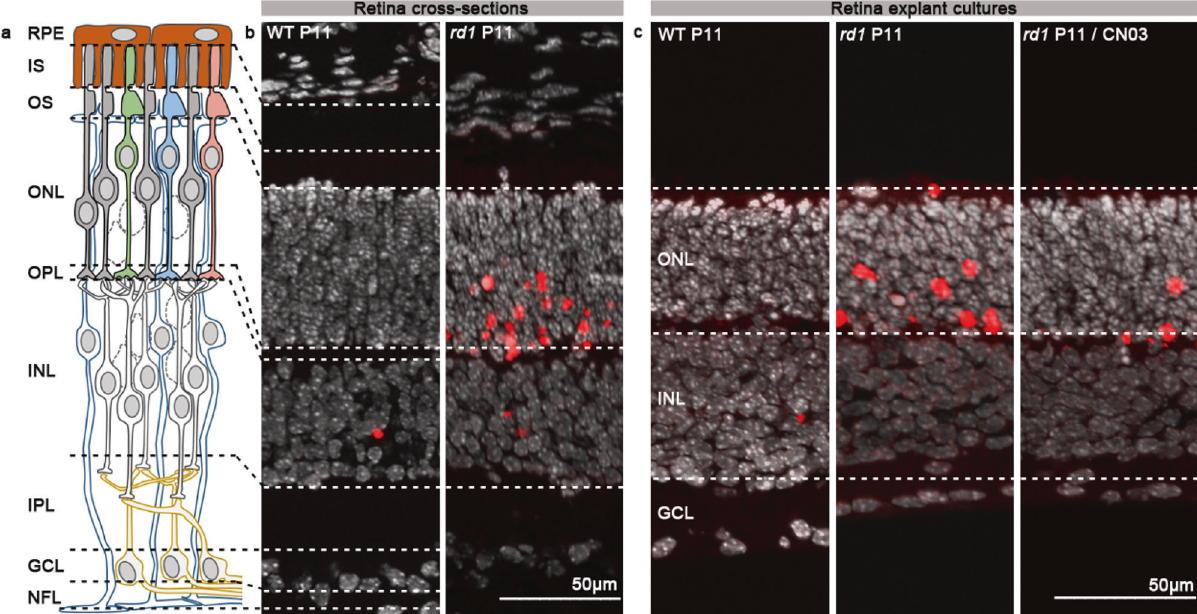
Fig. 1 CN03-mediated photoreceptor protection in rd1 P11 retinal explants. a Diagram showing retinal layers: RPE = retina pigment epithelium, IS Inner segment, OS Outer segment, ONL Outer nuclear layer, OPL Outer plexiform layer, INL Inner nuclear layer, IPL Inner plexiform layer, GCL Ganglion cell layer, NFL Nerve fi bre layer . b Retina cross-sections derived from WT and rd1 P11 mice. c Sections derived from WT and rd1 P11 retinal explant cultures untreated or treated from P7 to P11 with 50 µM CN03. In both b and c : TUNEL assay (red) indicated dying cells, DAPI (grey) was used as nuclear counterstain. P Postnatal